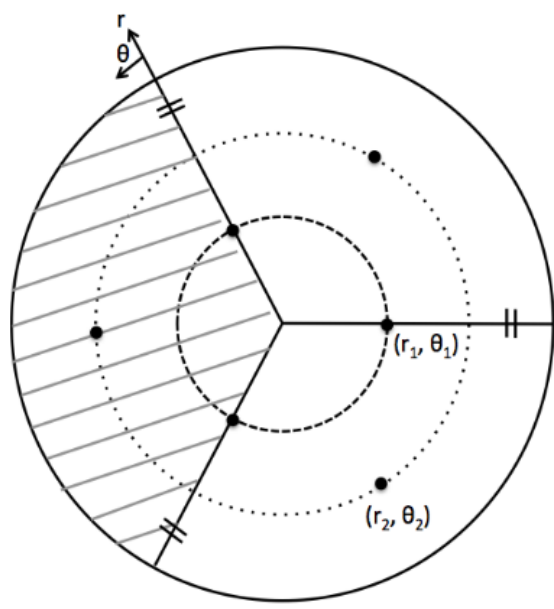
Figure 10. Periodicity assumptions.